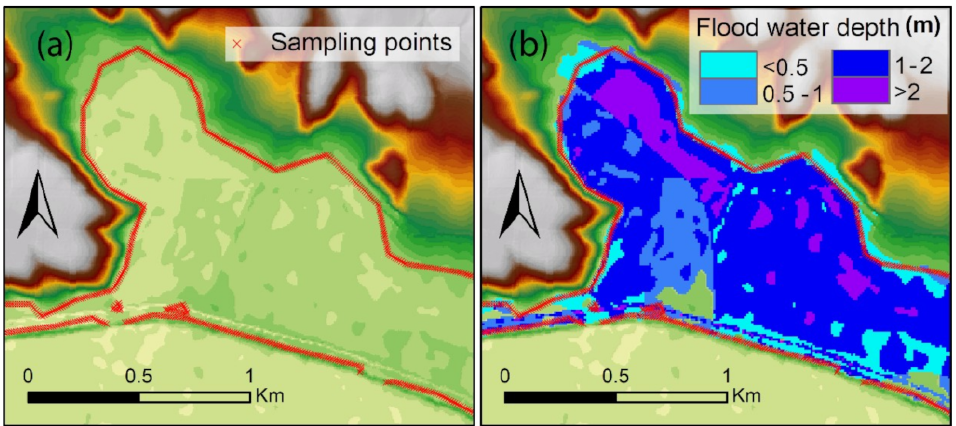
Figure 6. Flood water depth calculation example. ( a ) Sampling points at the RS polygons boundaries; ( b ) flood water depth